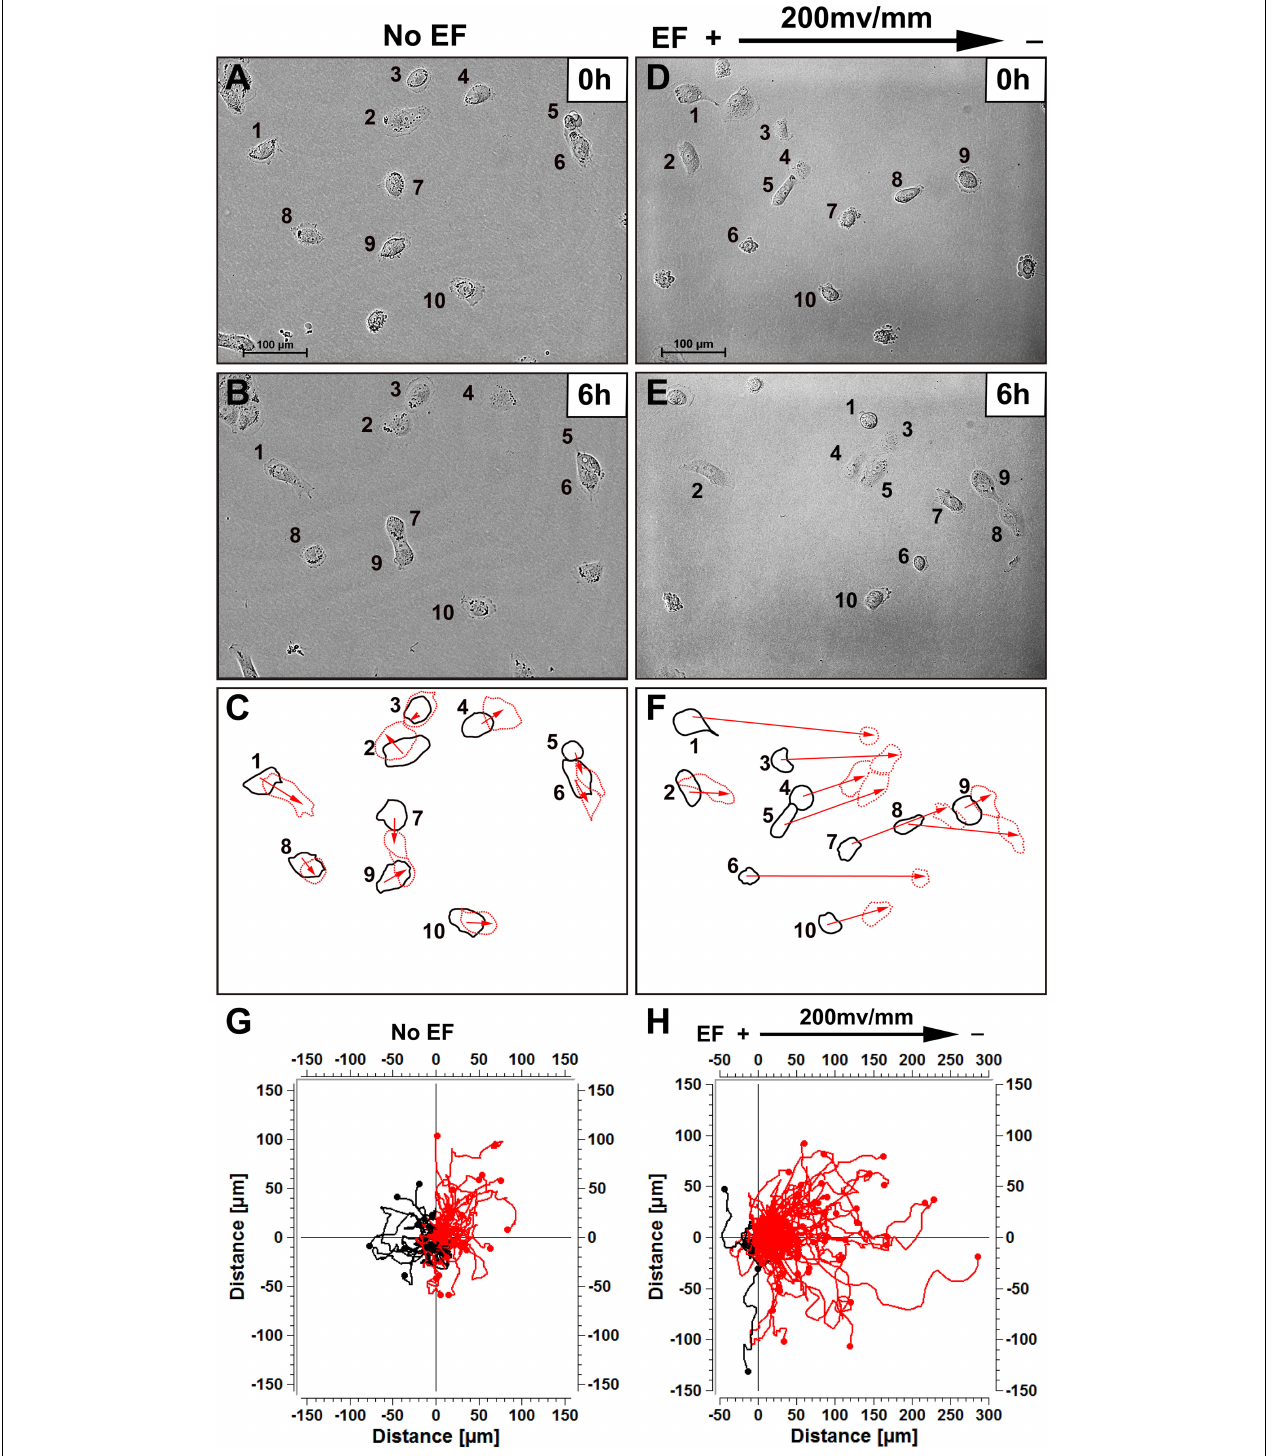
FIGURE 1 | Human renal tubular epithelial cells migrate cathodally in small physiological electric fields. (A,B) Random migration of cells over a 6 h period without EF stimulation. (D,E) Cells migrated to the cathode right in response to EF stimulation over 6 h (see “ Supplementary Video 1 ”). Cells are identified by numbering. (C,F) Show the outlines of the cells at the beginning and end of each experiment, with migration direction indicated by the arrows. In (G,H) each frame shows the superimposed migration tracks of 60–125 HK-2 cells from three different experiments. The position of all cells at t = 0 min is represented by the origin (0, 0). Each line represents the migration track of one single cell over a 6-h period. Scale bar = 100 µ m.